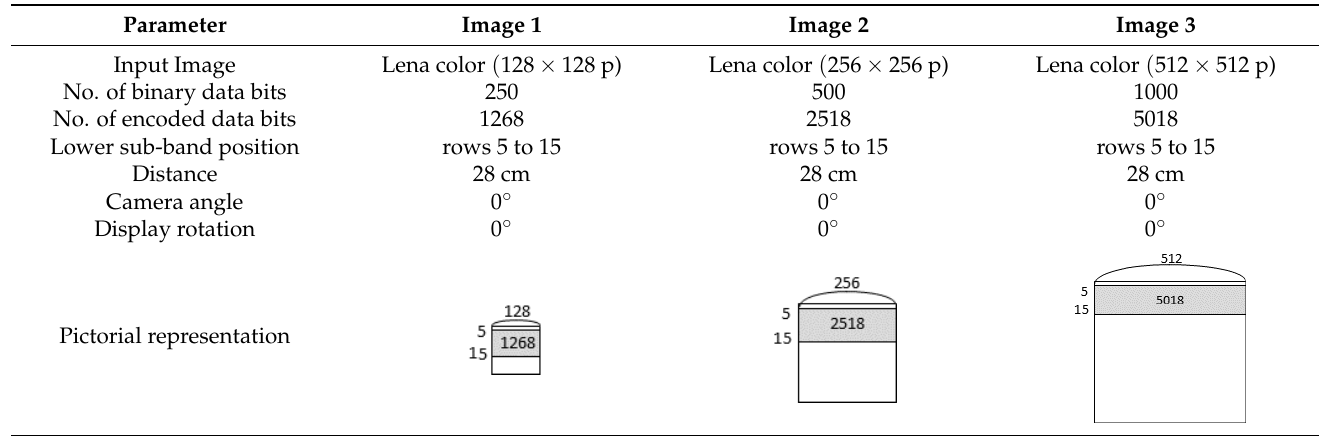
Table 4. Experimental parameters for different image sizes.